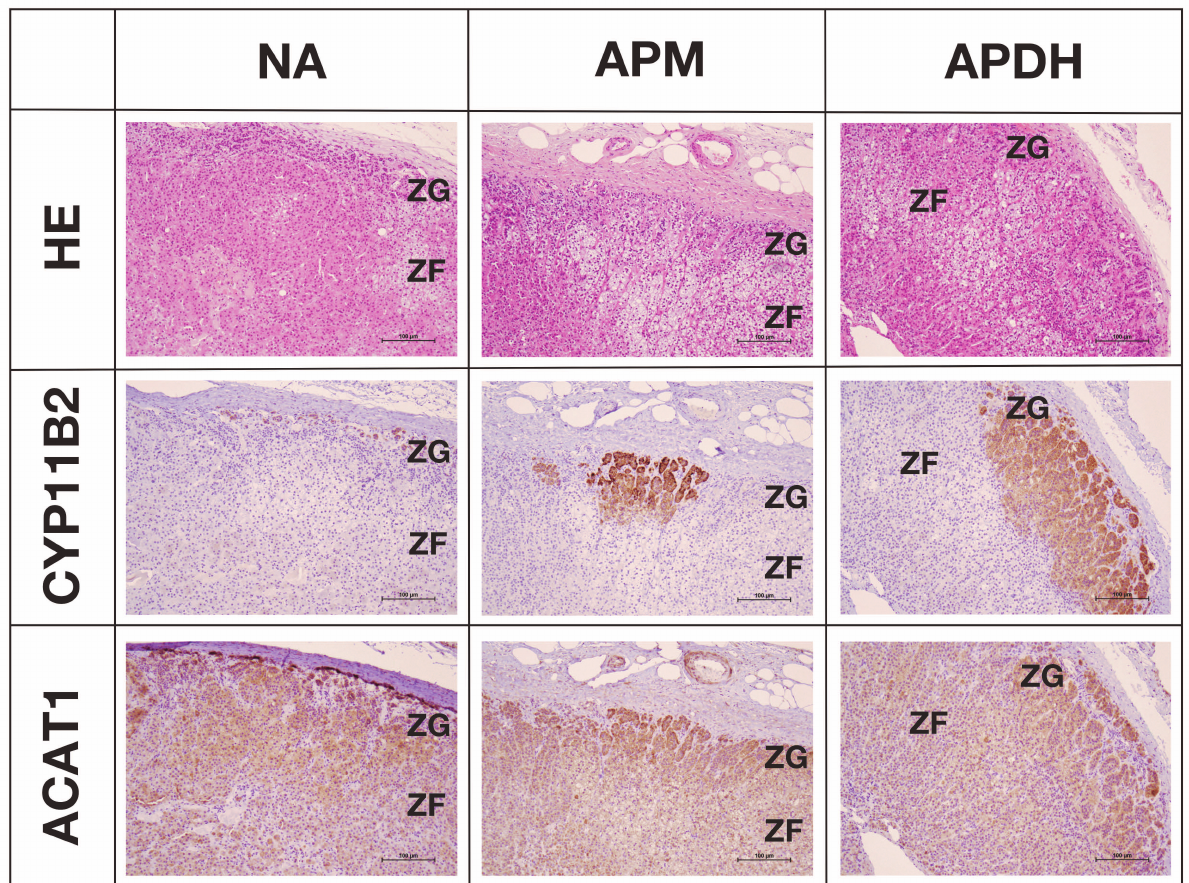
Figure 5. Expression and localization of ACAT1 in the adrenal cortex. HE: hematoxylin and eosin stains, CYP11B2: IHC using anti-CYP11B2 antibody, ACAT1: IHC using anti-ACAT1 antibody, NA: normal adrenal, APM: aldosterone-producing micronodule, APDH: aldosterone-producing diffuse hyperplasia. Scale in the image indicates 100 µ